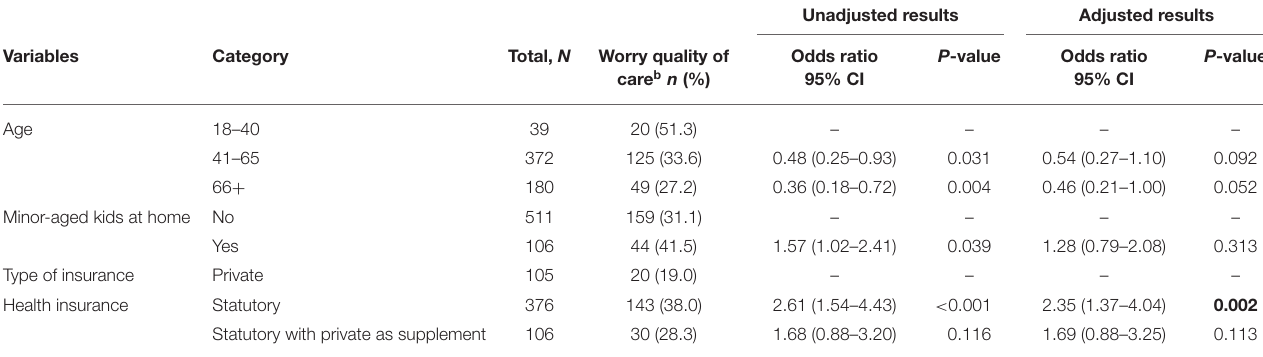
TABLE 5 | Logistic regression of associated factors for patient worry regarding effects of the pandemic affecting the quality of medical treatment a .